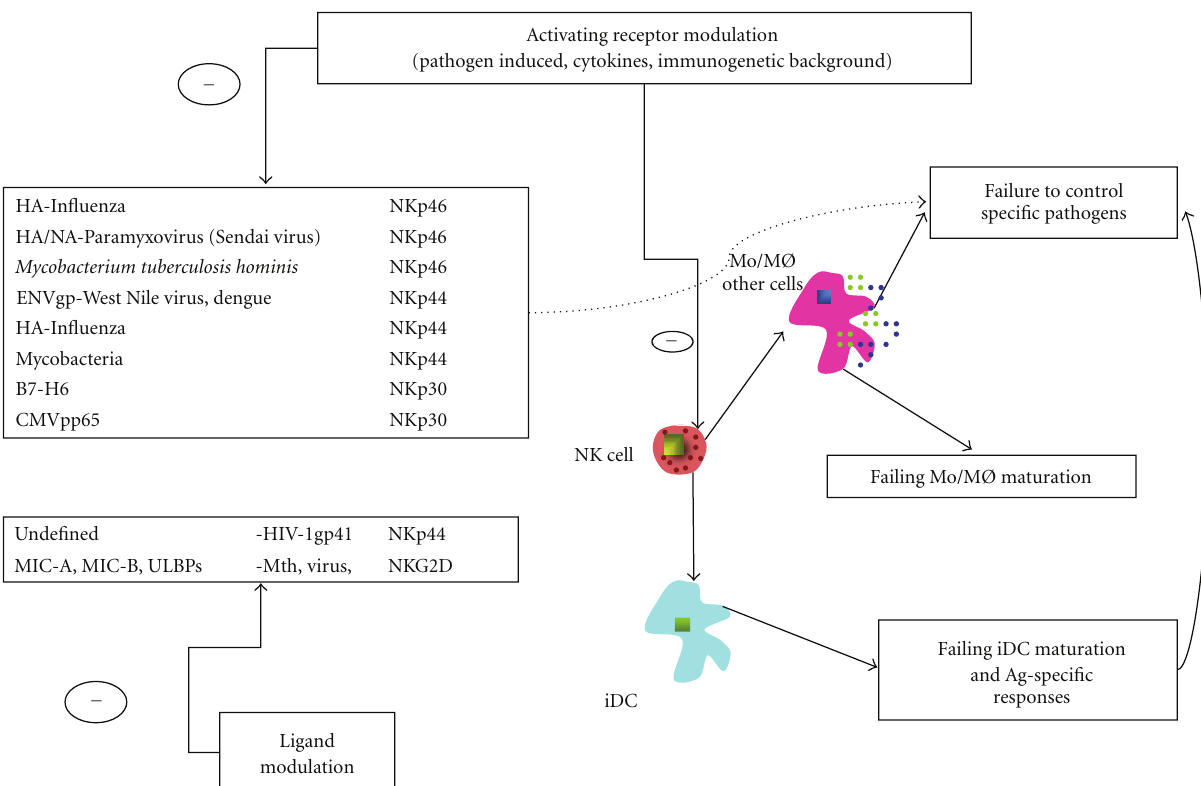
Figure 2: Diagram representing possible consequences of activating receptor modulation, alone, on the control of acute or chronic infec-